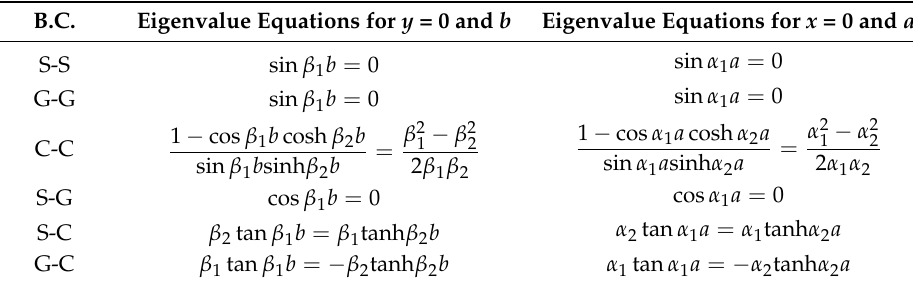
Table 2. Eigenvalue equations for various boundary